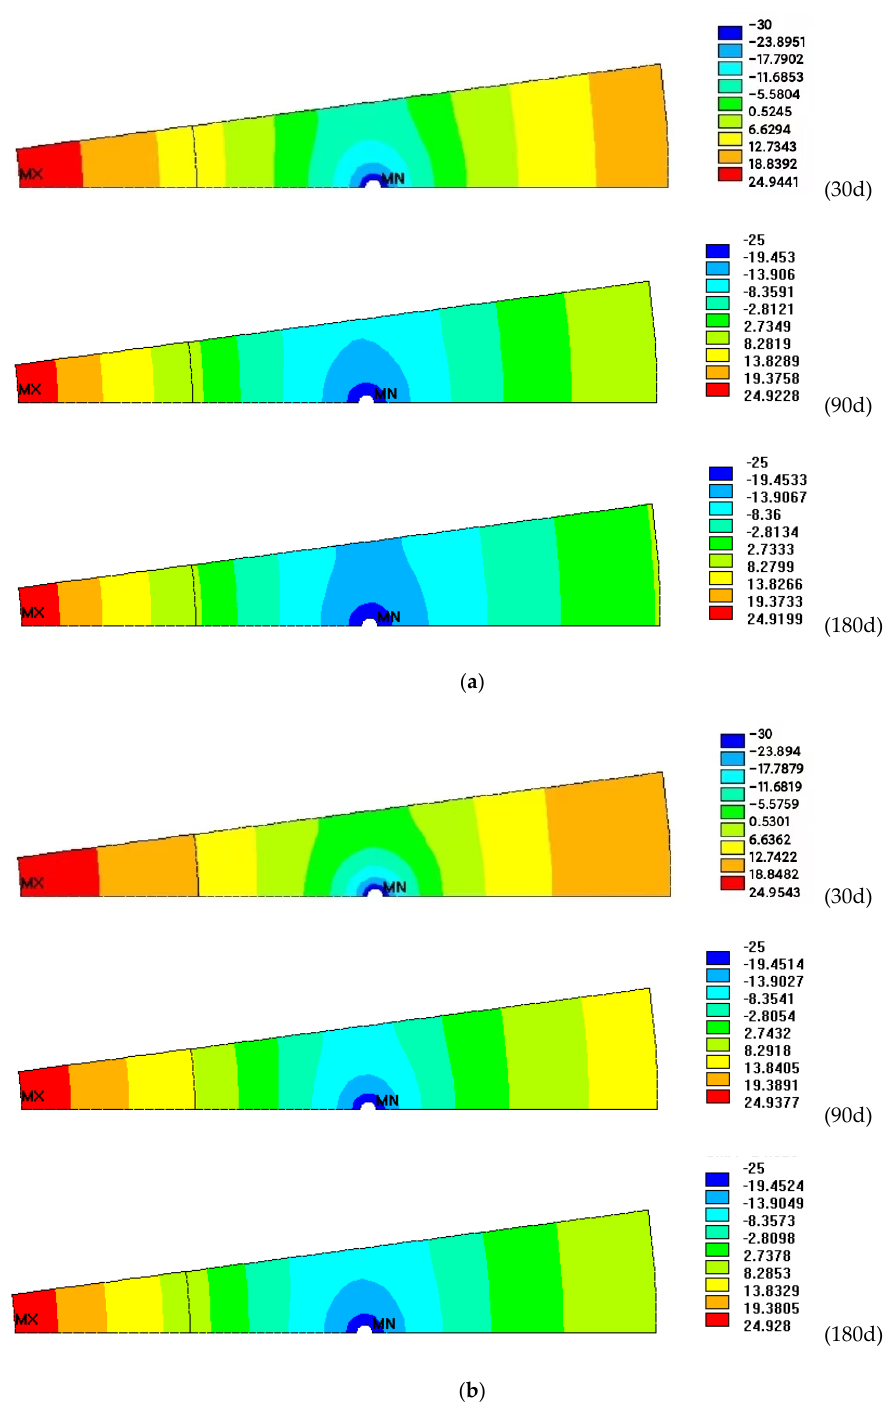
Figure 19. Temperature contours within 30 d, 90 d, and 180 d: ( a ) soil moisture content of 10%, ( b ) soil moisture content of